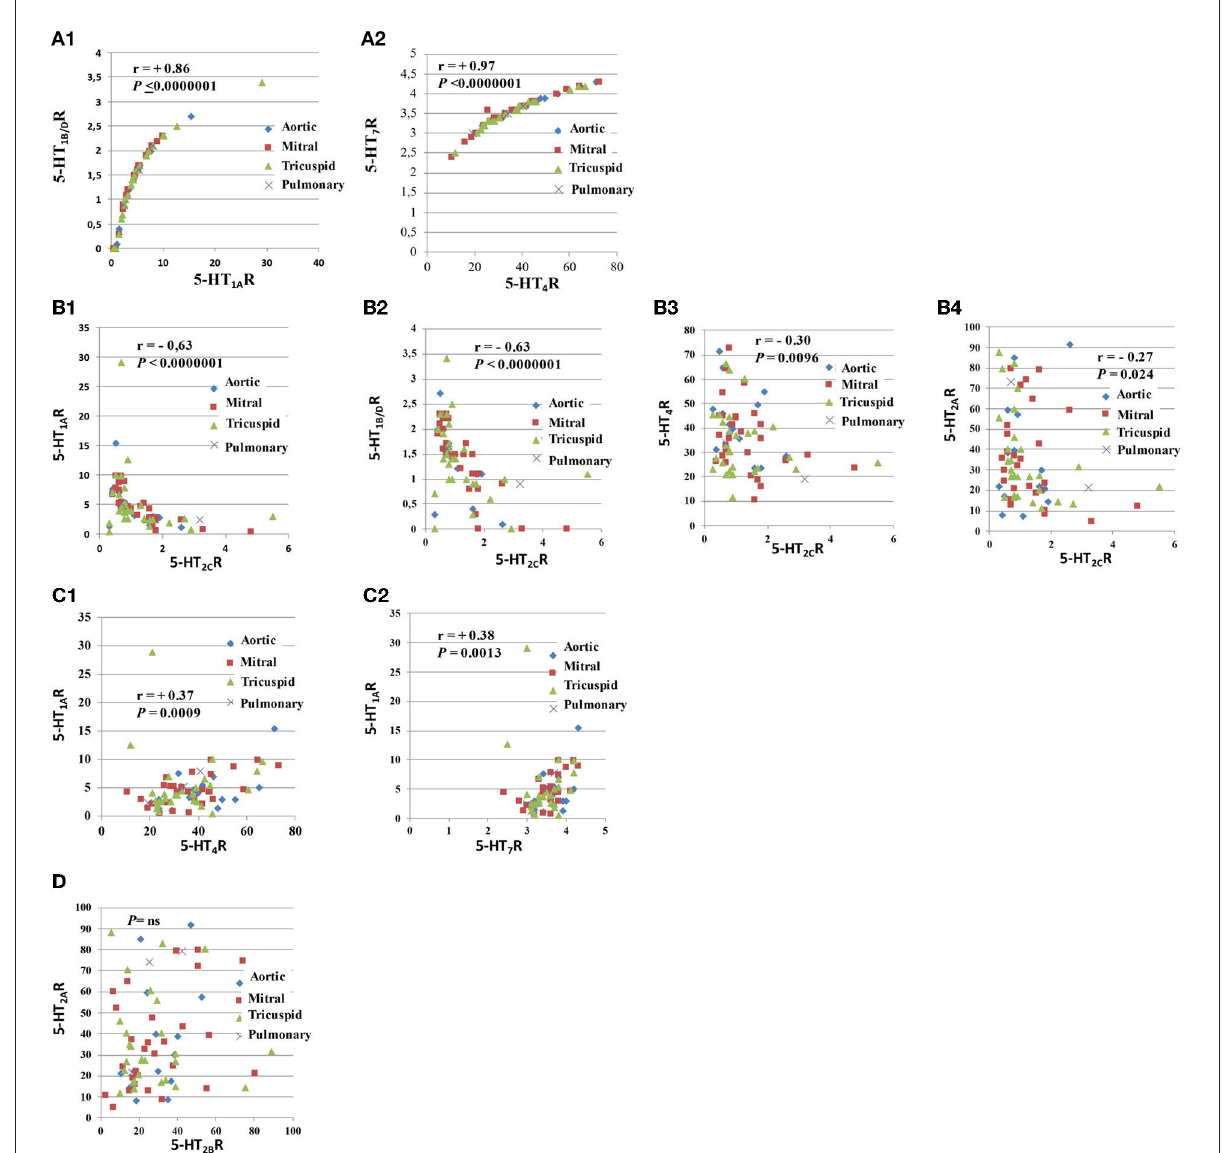
FIGURE2 Comparison of the levels of expression of different pairs of 5-HTRs. This figure corresponds to this figure. As shown in this figure, there were strong correlations between several 5-HTRs (A1–D) . The strongest correlations were found between the 5-HT 1A R and 5-HT 1B / D R quantitative protein levels (A1) and between 5-HT 4 R and 5-HT 7 R levels (A2) . 5-HT 1A R and 5-HT 1B / D R are coupled with the same G protein (i.e., Gi/Go), while 5-HT 4 R and 5-HT 7 R are coupled with G protein Gs. We observed that 5-HT 2C R levels were negatively correlated with all other 5-HTRs (C) . The negative correlation between 5-HT 2C R levels and other 5-HT2Rs (i.e., 5-HT 2A R or 5-HT 2B R) was less marked (B4) . We also observed positive correlations between receptors coupled with different G proteins: 5-HT 4 R levels were negatively correlated with 5-H 1A R levels (C1) and 5-HT 1A R levels with 5-HT 7 R levels (C2) . There was no correlation between 5-HT 2A R levels and 5-HT 2B R levels after univariate analysis (D) . Respective correlations following univariate analyses are shown in different panels. All correlations between 5-HTRs following univariate analysis are presented in Table 2. Spearman’s Rank Correlation analysis ( n = 70 samples for each